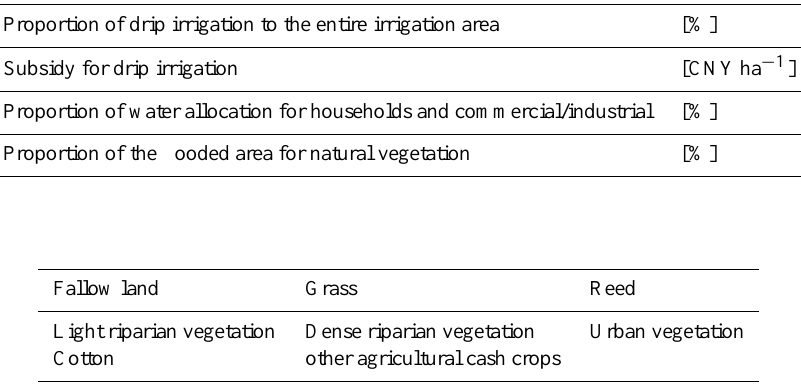
Table 4. Management indicators for the design of management measures in the DSS.